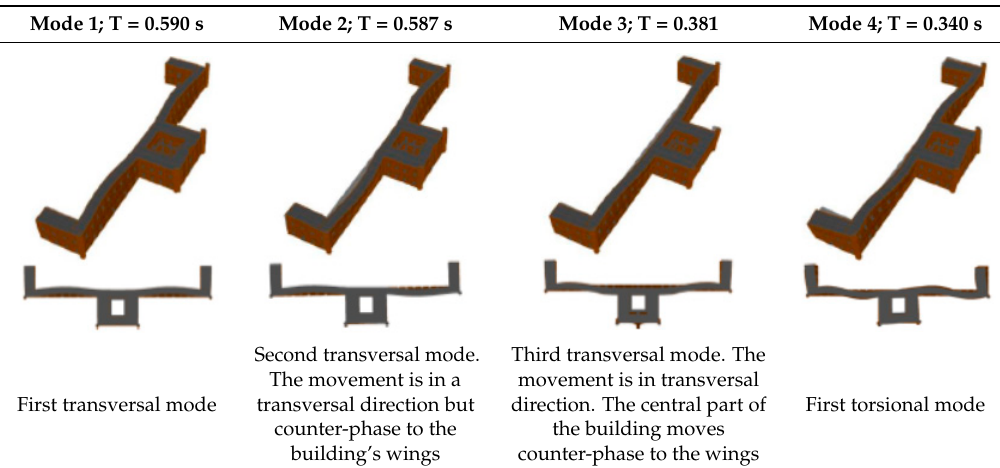
Table 6. Characteristics of the first 4 vibration